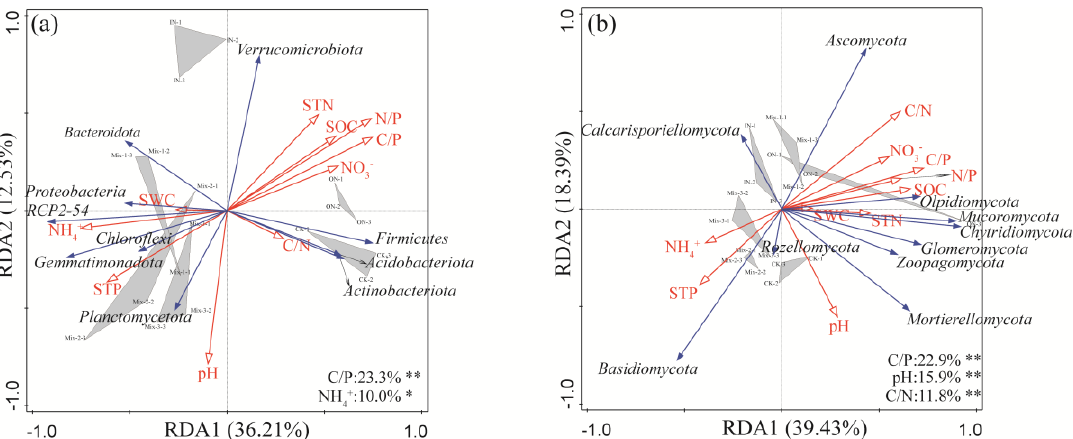
Figure 5. Redundancy analysis (RDA) of soil properties and dominant bacterial phyla ( a ) and dominant fungal phyla ( b ). Abbreviations: NO 3 − , nitrate nitrogen; NH 4 + , ammonium nitrogen; STN, total nitrogen; SOC, soil organic carbon; STP, total phosphorus; SWC, soil water content. Mean ± standard error, n = 3. * p < 0.05 and ** p < 0.01.